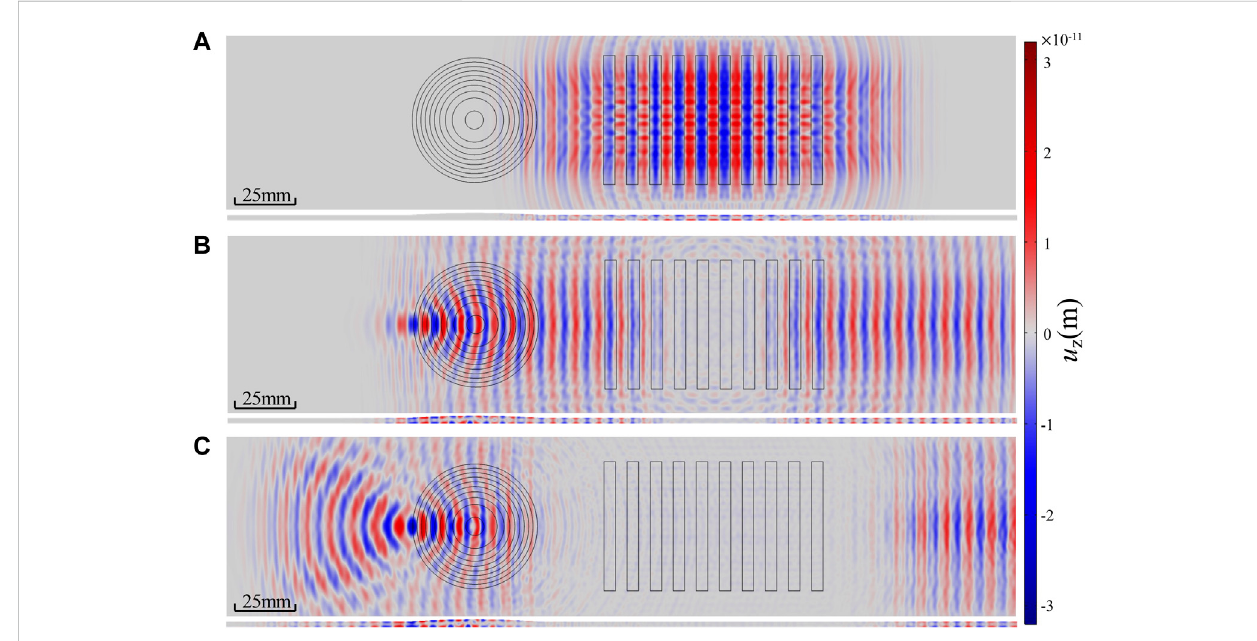
FIGURE 6 The focusing phenomenon of the A1-wave-based Luneburg lens at 1 MHz: (A) t = 15 μ s, (B) t = 30 μ s and (C) t = 45 μ s.